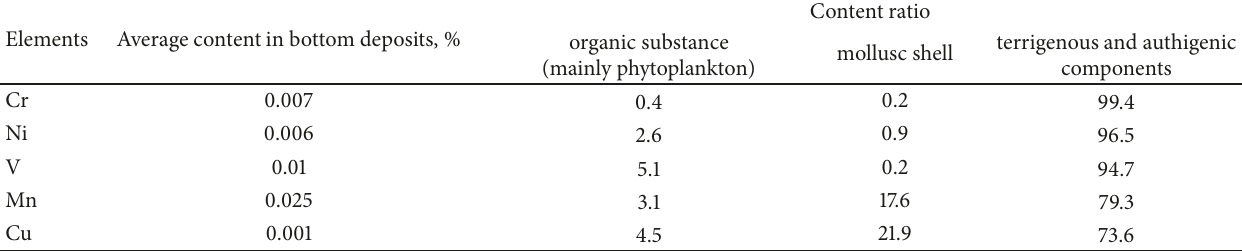
Table 4: Trace minerals in components of bottom deposits of the Azov Sea, %%.